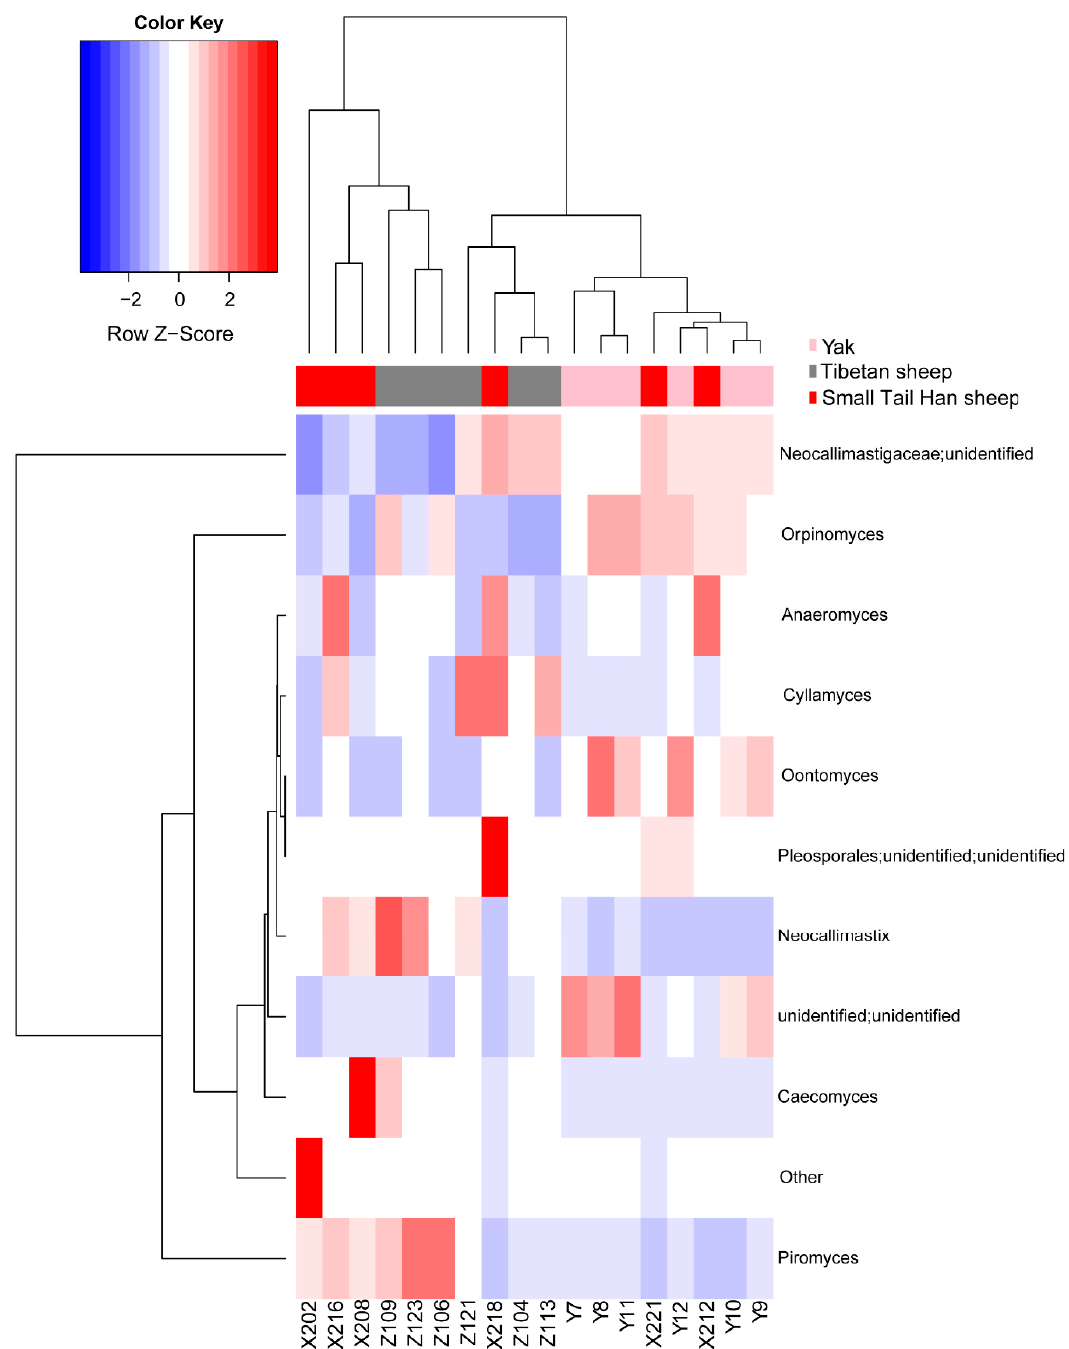
Figure 4. Genus or higher-level fungal profiles of each sample in three animal species, with the values of log10 transformed.